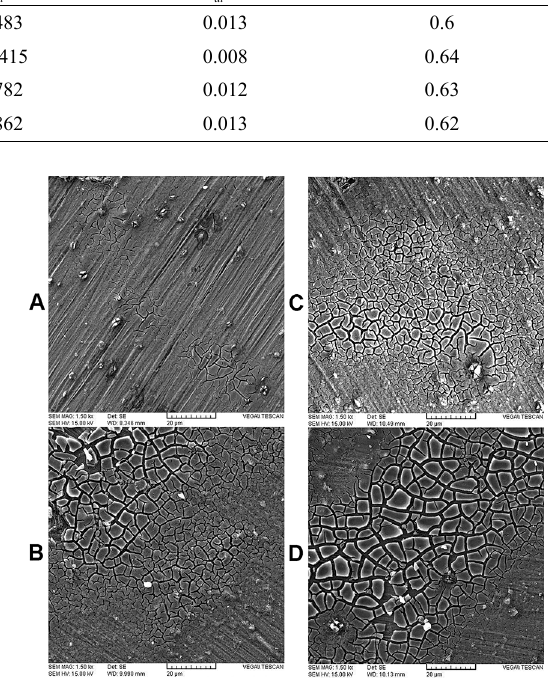
Figure 6. SEM micrographs of steel samples coated at different immersion times in cerium chloride solution: (a) 20 s, (b) 40 s, (c) 60 s, and (d) 120 s.